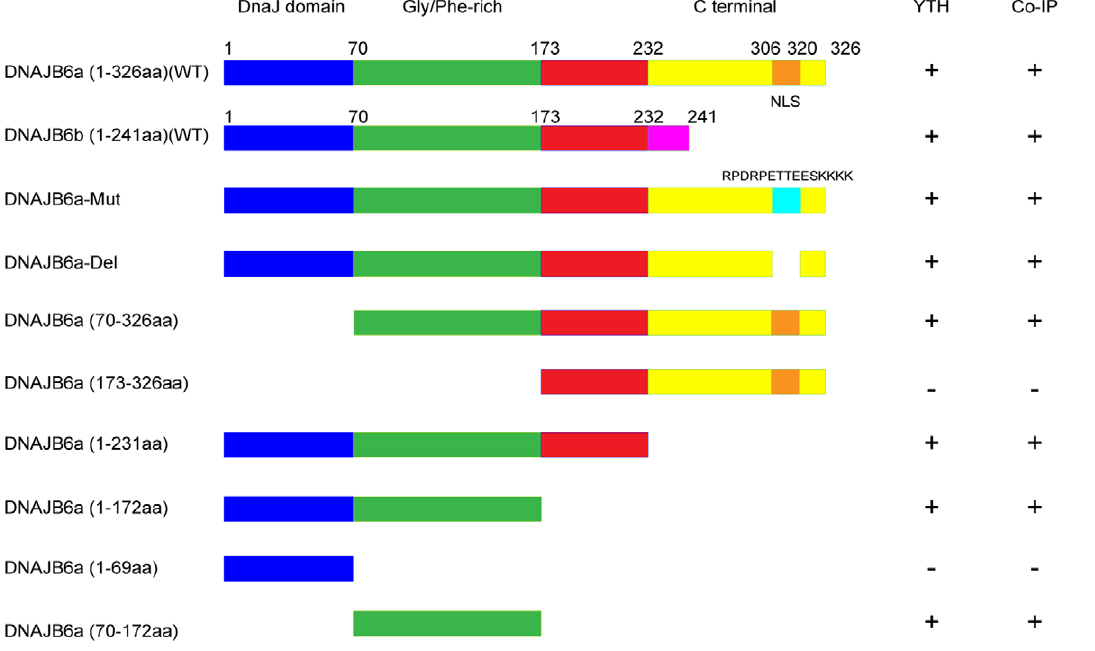
Figure 2. Schematic diagram of DNAJB6a and DNAJB6b and their deletion mutants that interact with UL70 as identified by the two hybrid screen in yeast (YTH) and co-immunoprecipitation (co-IP) in U251 cells. DNAJB6 (a and b) proteins share the N-terminal 231 amino acids, which include the highly conserved DnaJ homology region (in blue), a Gly/Phe-rich region (in green), and a linker region (in red) but differ at the less conserved C-terminal region (in yellow and pink for DNAJB6a and b, respectively) in which a NLS (in orange) is present in the longer DNAJB6a but is absent in the shorter DNAJB6b [38,40]. The NLS was mutated and deleted in mutants DNAJB6a-Mut and DNAJB6a-Del, respectively. The interactions that were positive and negative in the two hybrid screen or co-IP were marked as ‘‘ + ’’ and ‘‘ 2 ’’,